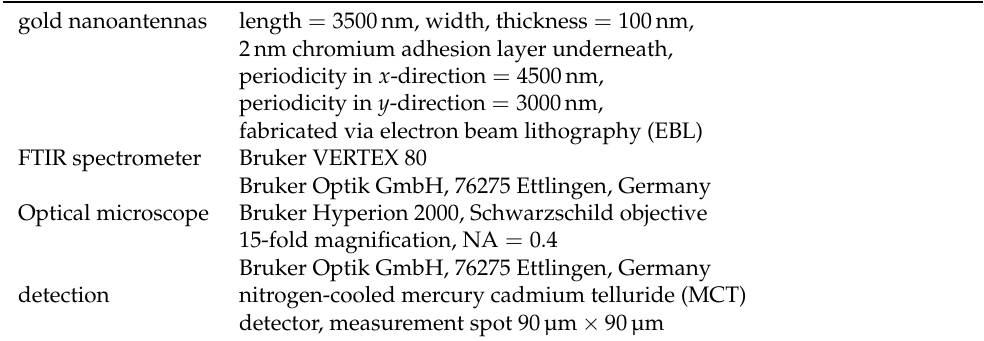
Table A1. Technical equipment used for recording the